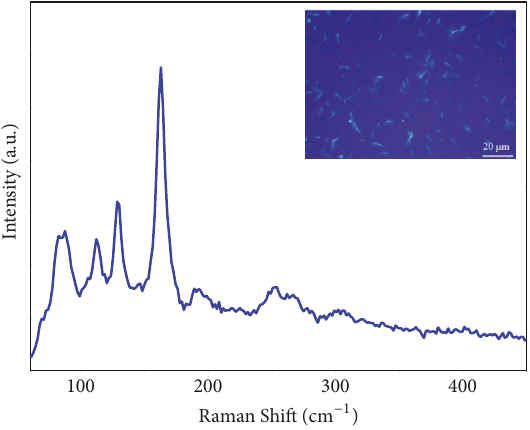
Figure 1: Raman spectra of the few-layer MoTe 2 , and the inset shows its SEM